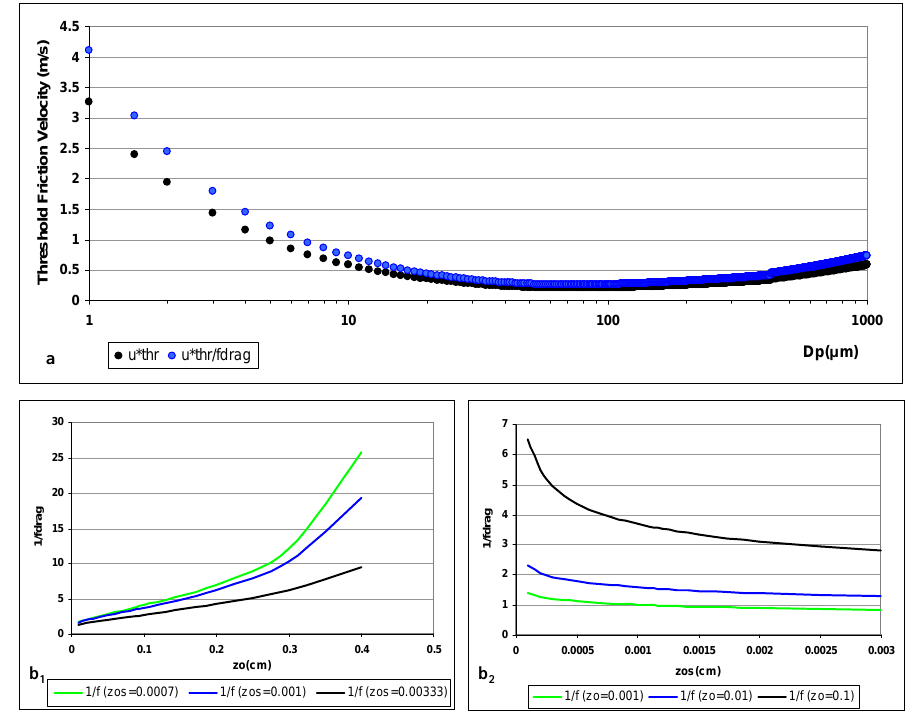
Fig. 2. (a) Dependence of the threshold friction velocity on the diameter of the soil particle. The blue dots correspond to the correction of the threshold friction velocity from the drag partition scheme when f drag is constant. (b) Dependence of the drag correction parameter on the aerodynamic roughness length z o (left), and the smooth roughness length z os